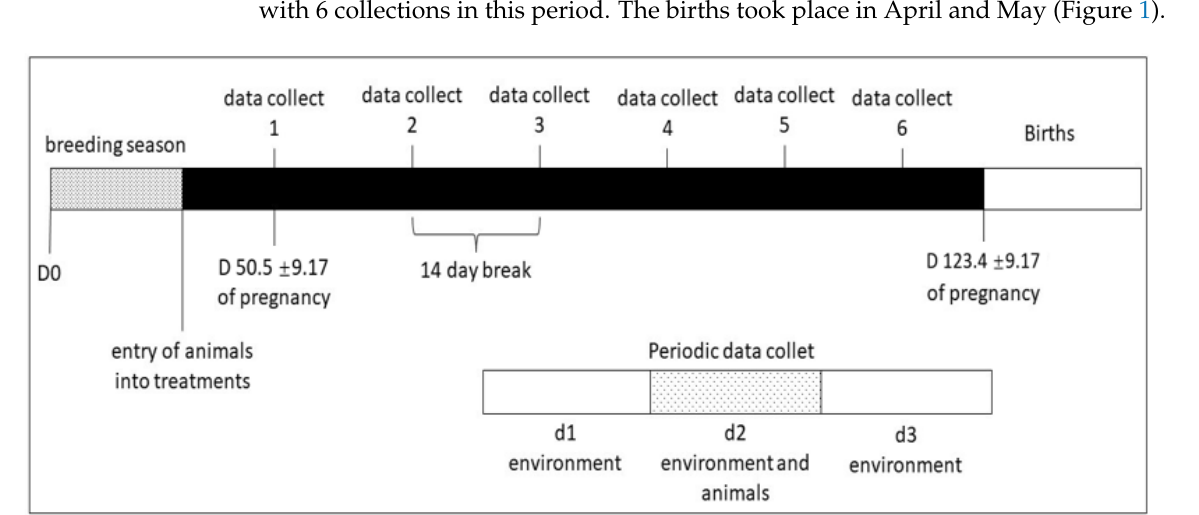
Figure 1. Representation of the breeding season scheme, periodic collections (main and microclimatic), and calving period.